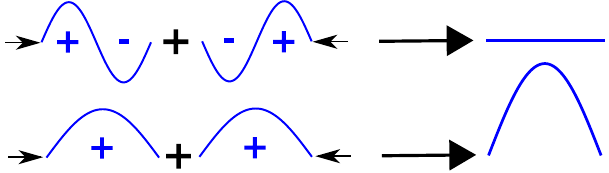
Figure 4. The interferometric control of the absorption in patch antennas summarized in normal incidence: adding two anti-symmetric modes excited from left and right leads to a complete cancellation, while adding even modes leads to an enhancement. For oblique incidence, this control is lowered, so that the even modes don’t completely cancel each other, and the odd modes are less enhanced.